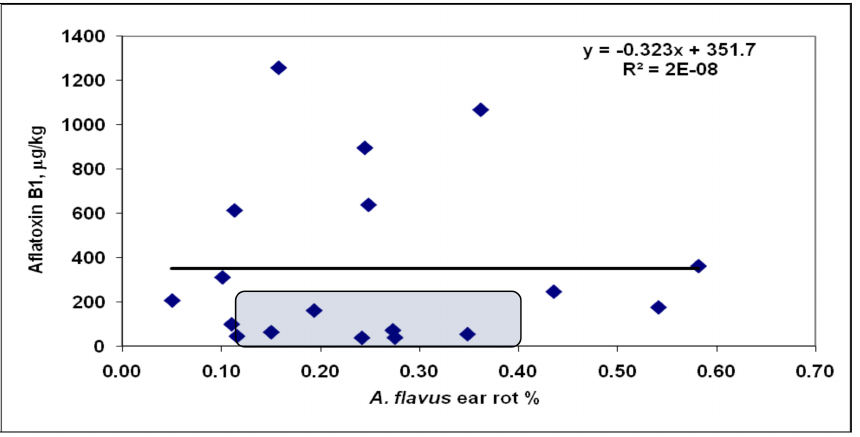
Figure 6. A. flavus ear rot and AFB1 production in the commercial hybrids following artificial inoculation (Szeged, 2019–2020). The four data sets differed so much that even large differences with a significant LSD could not be demonstrated. The variance for AFB1 can be found for each genotype in Table S6.